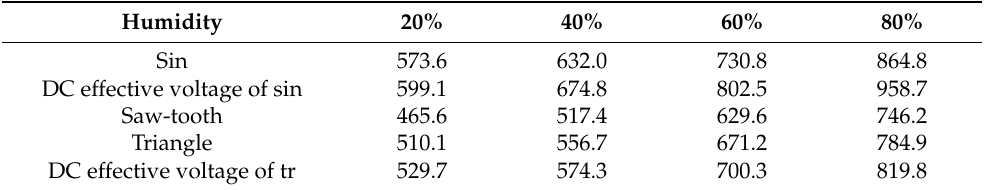
Table 2. The equilibrium position (um) under different voltage waveforms and different ambient